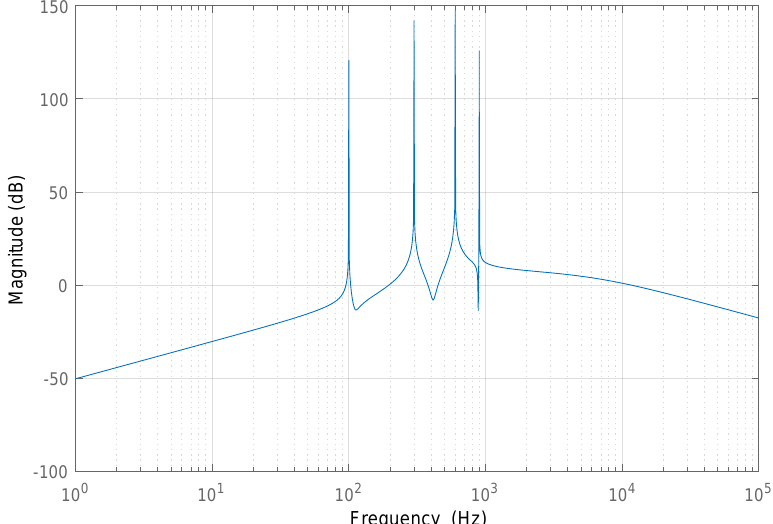
Figure 7. Magnitude (dB) of the Bode plot for several resonant controllers.